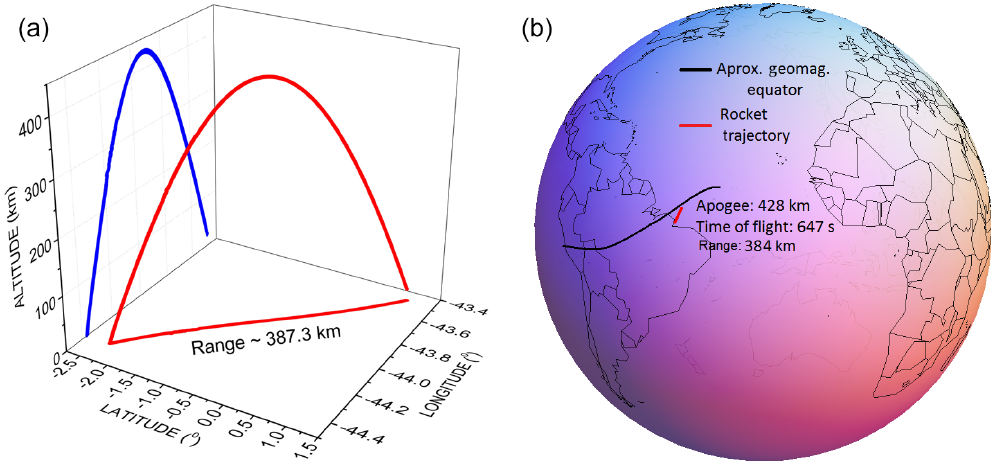
Figure 1. Rocket trajectory (a) and flight details (b) . The blue parabola in (b) is the projection of the trajectory onto a vertical